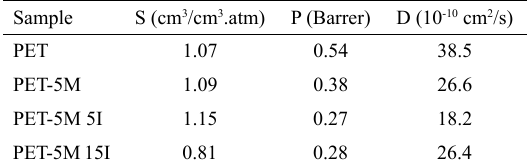
solubility coefficient (S), permeability (P) and Table 3. Values of CO 2 diffusion coefficient (D) of the PET/o-Mt nanocomposites at 2 atm. Sample